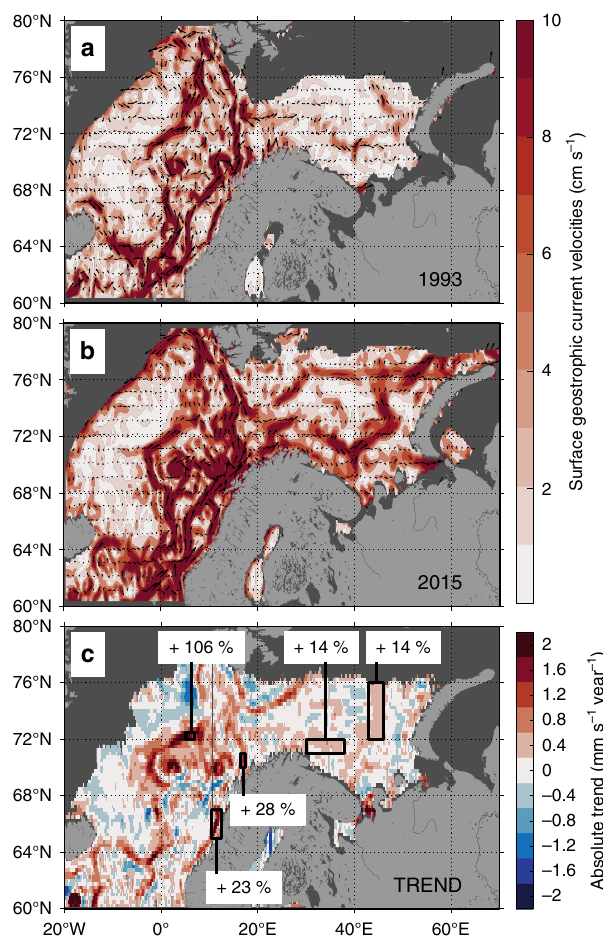
Fig. 3 Increasing current velocities in the European Arctic Corridor. Surface absolute geostrophic velocities during the extremums of the time- series which are, respectively, reached in December 1993 ( a , minimum) and 2015 ( b , maximum) with the corresponding absolute linear trend of the entire time-series (all months) over the 1993 – 2016 period ( c ). Areas covered by sea ice (sea-ice concentration > 15%) or with insuf fi cient data coverage for the trend (<50%) are in dark gray.